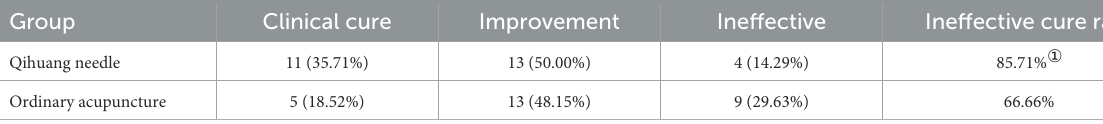
TABLE 5 Statistics of the composition ratio of clinical efficacy in two groups. Group